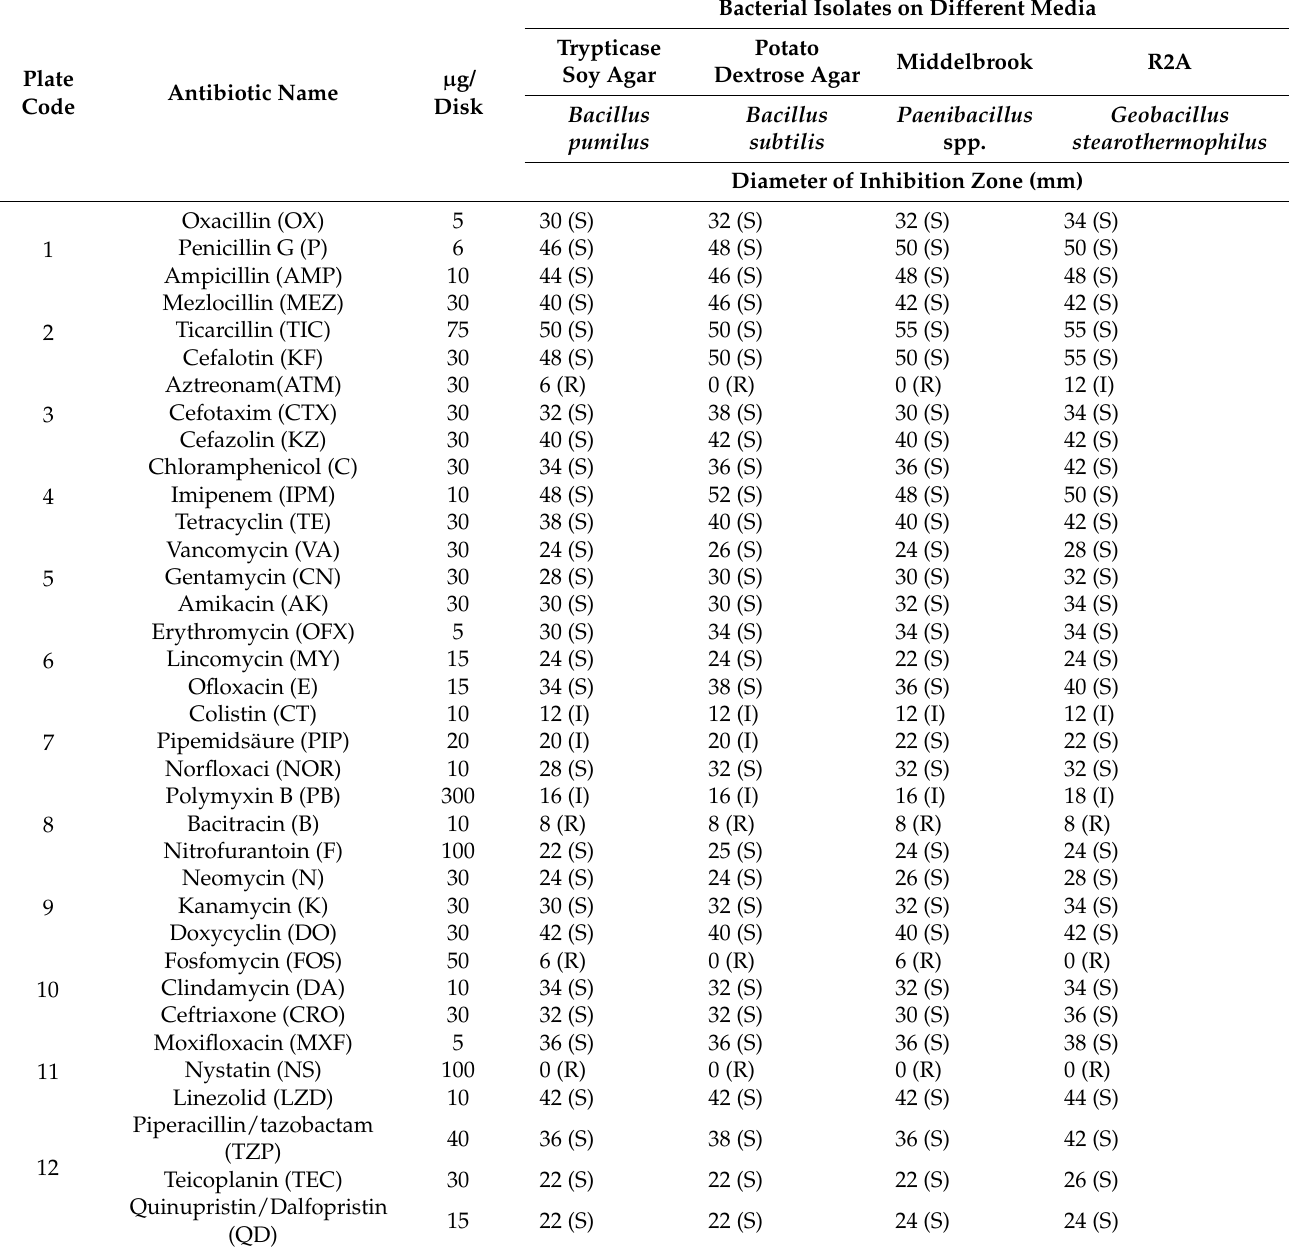
Table 1. Antibiotics susceptibility of bacterial isolates from banana ‘Grand Naine’ in vitro culture to different